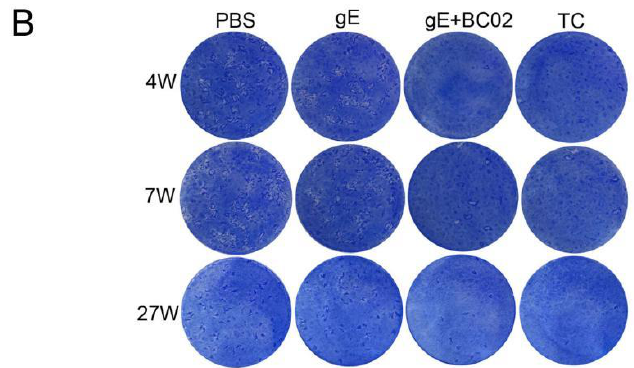
Figure 6. Inhibitory rate of VZV plaque formation by serum antibodies of immunized mice at different time points. ( A ) The immunized mouse serum was diluted at ten-fold and changes in inhibition of VZV plaque formation in different immunization groups with time were measured. ( B ) VZV plaque formation counts in different immunization groups at 4W, 7W, and 27W (Sera from 6 mice were pooled). TC is the abbreviation of test control.